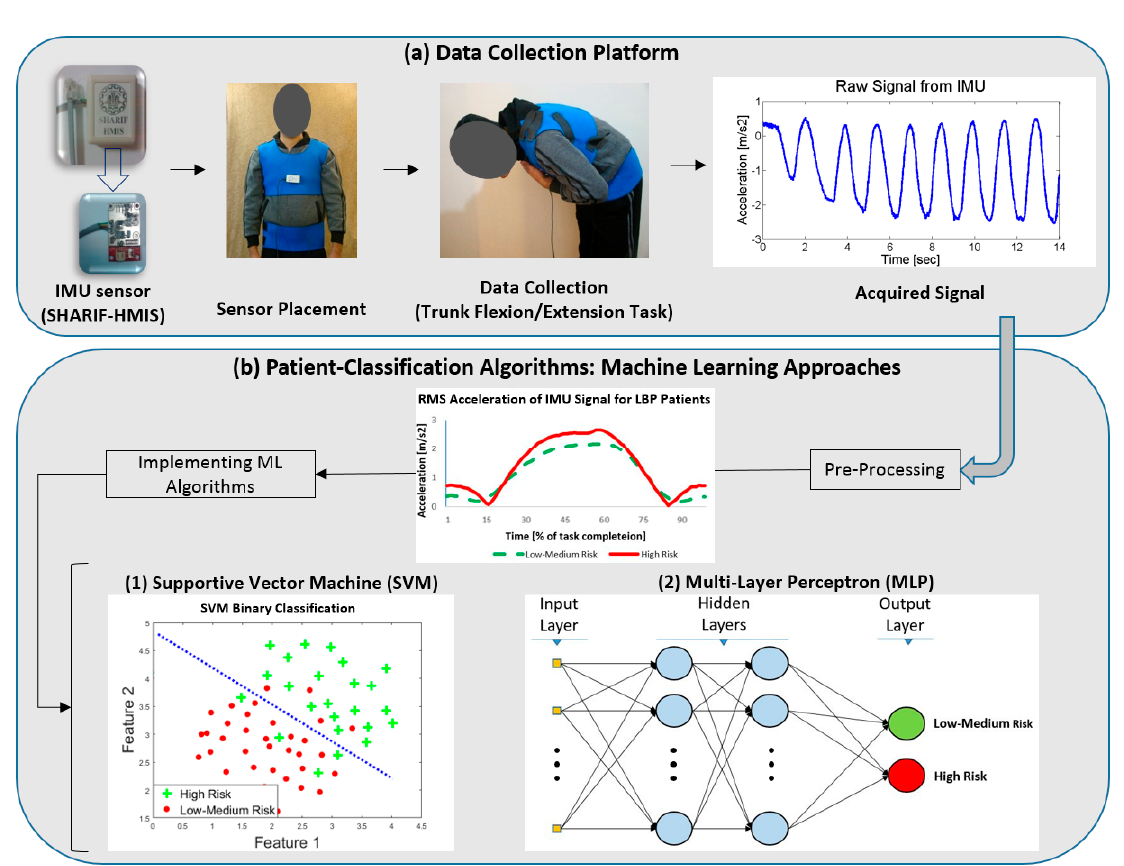
Figure 1. Schematic system diagram of the platform for the classification of NSLBP (nonspecific low back pain) patients. ( a ) Sensor and data collection procedure. ( b ) Data analysis procedure.